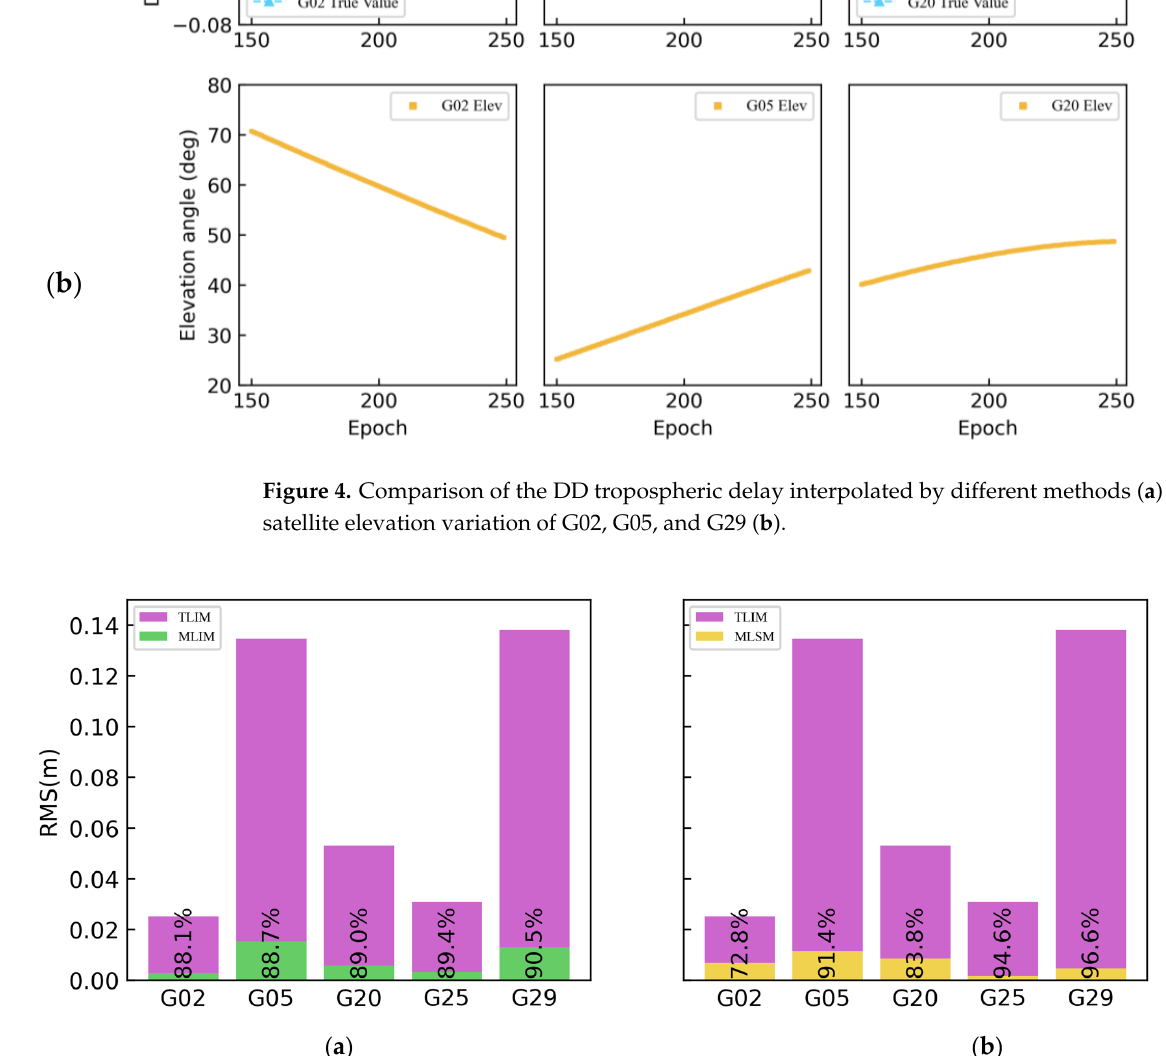
( c ) Figure 6. Variation trend of DD tropospheric errors for different satellites with a change in elevation calculated by TLIM ( a ), MLIM ( b ), and LSM ( c ). 3.2.2. Tropospheric Delay Interpolation Analysis for Dataset 2 Since dataset 2 contains GPS and BDS satellites, we analyzed the tropospheric delays obtained by different interpolation methods for satellites in the two systems, and the results are shown in Figure 7. For GPS satellites, as shown in the results for G22, the DD tropospheric delays by three interpolation methods were consistent with the true values due to the higher elevation angle. However, the satellite elevation angles for G31 and G32 exhib- ited a declining trend. With the satellite elevation angle decreases, the result of TLIM deviates greatly from the true value, while MLIM and MLSM are closer to the true value. These results indicate an obvious error gap between the results acquired through the TLIM and the true value, whereas the results obtained using the MLIM and MLSM methods were extremely close to the true value and eliminated the systematic errors that occurred under the TLIM. For example, for G31 and G32, the largest offset between TLIM and the true values reached 0.04 and 0.03 m, respectively. However, the differences between MLIM or MLSM and the true values remained within 0.01 m. We also compared three different types of BDS satellites: C02 (Geostationary Orbit, GEO), C09 (Inclined Geosynchronous Orbit, IGSO), and C12 (Middle Earth Orbit, MEO). As shown in Figure 7, since C02 is a GEO satellite, its orbit is geostationary; thus, its elevation angle remains almost constant. However, the trop- ospheric interpolation results obtained by TLIM significantly depart from the true value, and the maximum